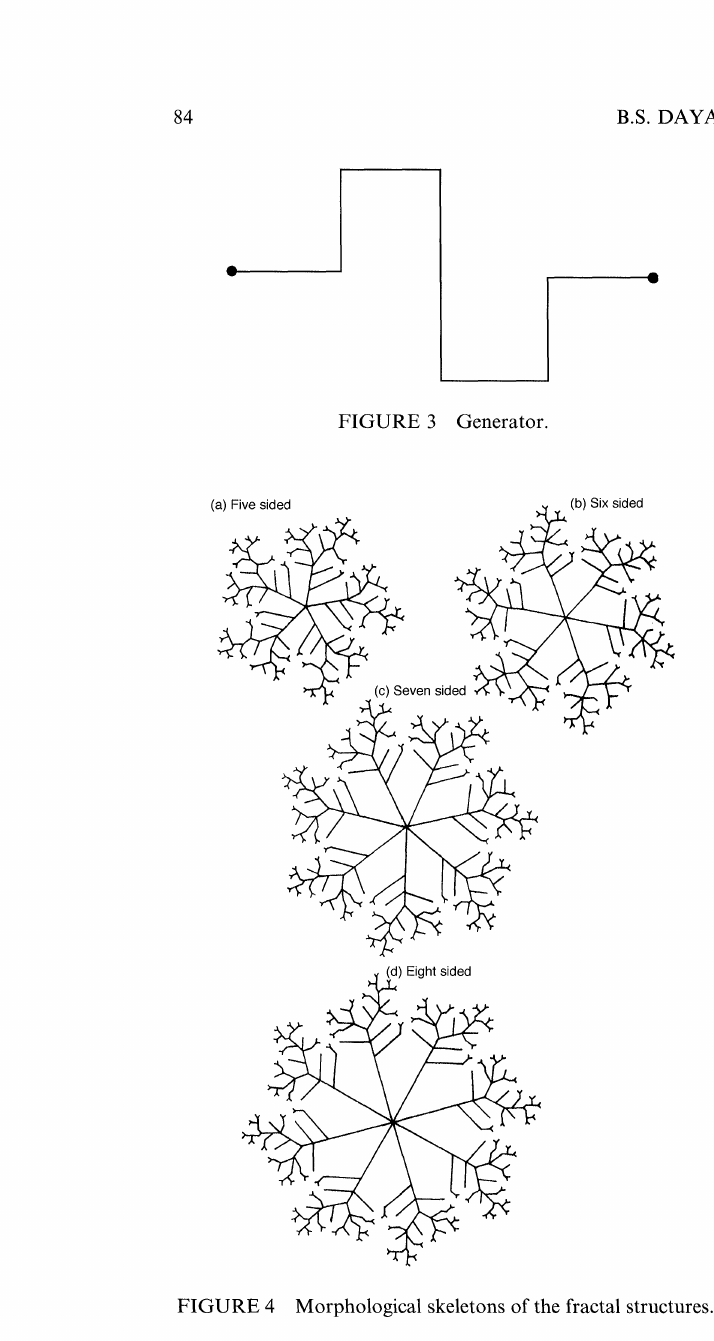
FIGURE 4 Morphological skeletons of the fractal structures. number of sides of the polygon) are same as the ones considered